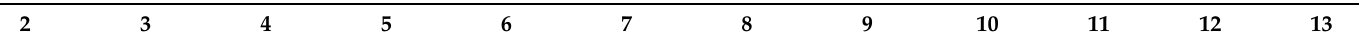
Table 5. Descriptive statistics and correlation matrix for explanatory variables on the financing